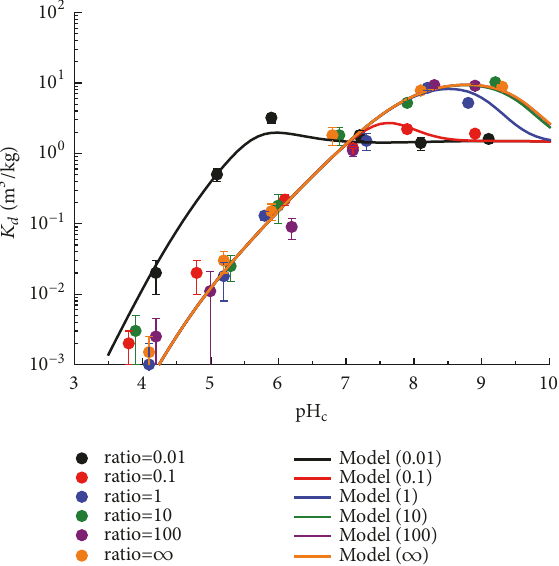
Figure 2: pH c and Cl − /ClO 4− molar concentration ratio depen- dence of 𝐾 𝑑 in Na-Ca-Cl-ClO 4 solutions at I = 4 M. Plots are the experimentally measured 𝐾 𝑑 values. The solid lines are the 2SPNE SC/CE model calculation results. The error bars represent the standard deviation of triplicate